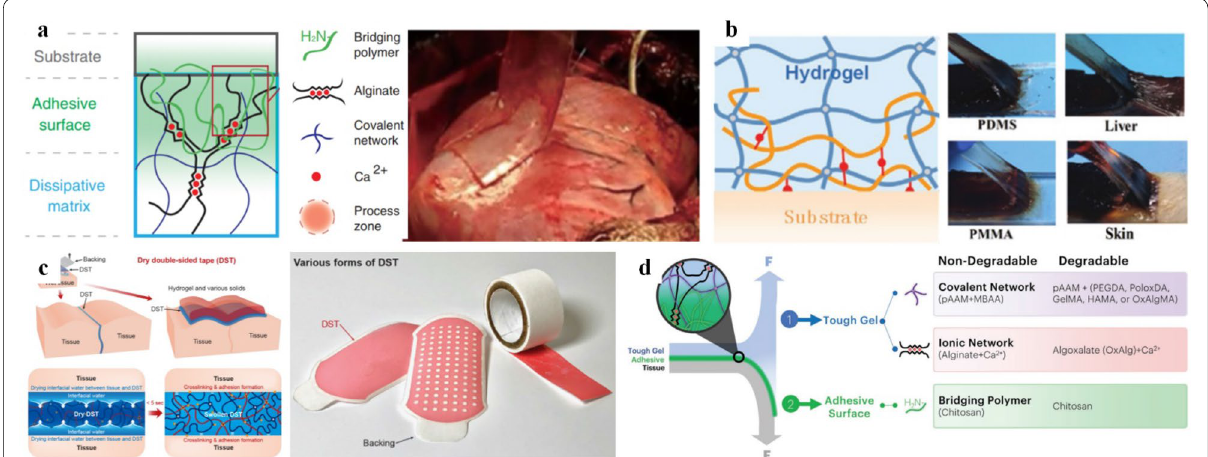
Figure 8 Bioinspired adhesives for medical devices: ( a ) tough adhesive for wet surfaces, ( b ) tough adhesive for wet and soft materials, ( c ) dry tape for wet tissues and devices, and ( d ) tough adhesive